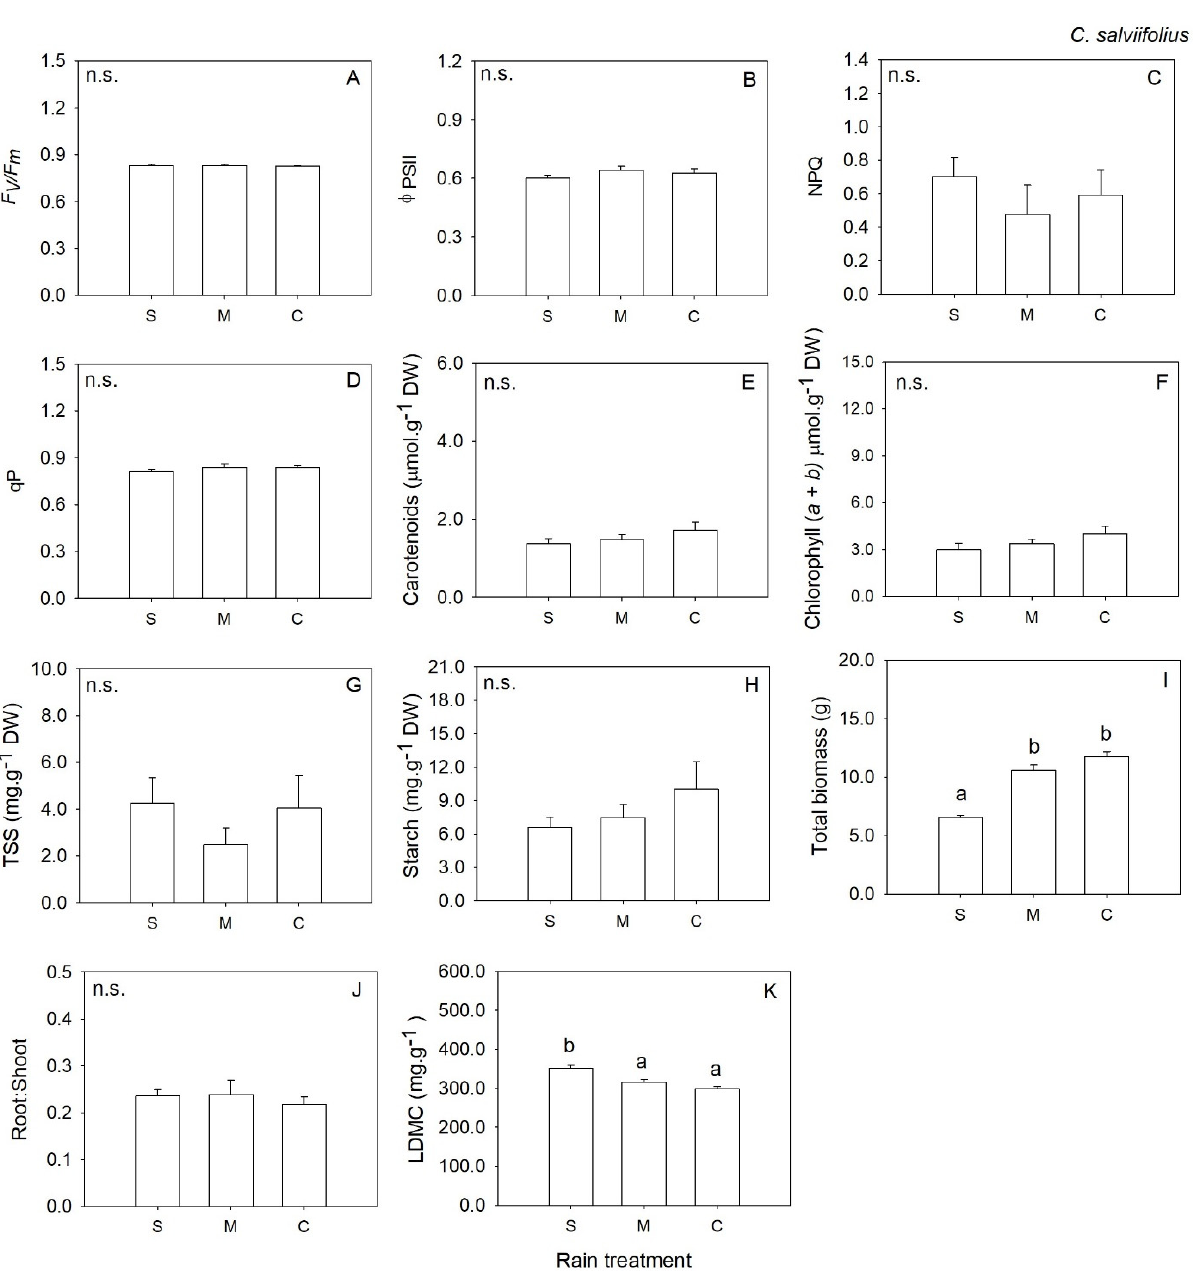
Figure 5. Mean values (+SE) of maximum quantum efficiency of photosystem II ( A ), the effective quantum efficiency of PSII ( B ), non-photochemical quenching ( C ), photochemical quenching ( D ), carotenoids content ( E ), chlorophylls ( a + b ) ( F ), total soluble sugars ( G ), starch content ( H ), total biomass ( I ), root to shoot biomass ratio ( J ) and Leaf Dry Matter Content ( K ) Cistus salviifolius grown under severe water deficit (S), moderate water deficit (M) and control (C) conditions. Significant differences at p < 0.05 among treatments are indicated by different letters. n.s., not significant.